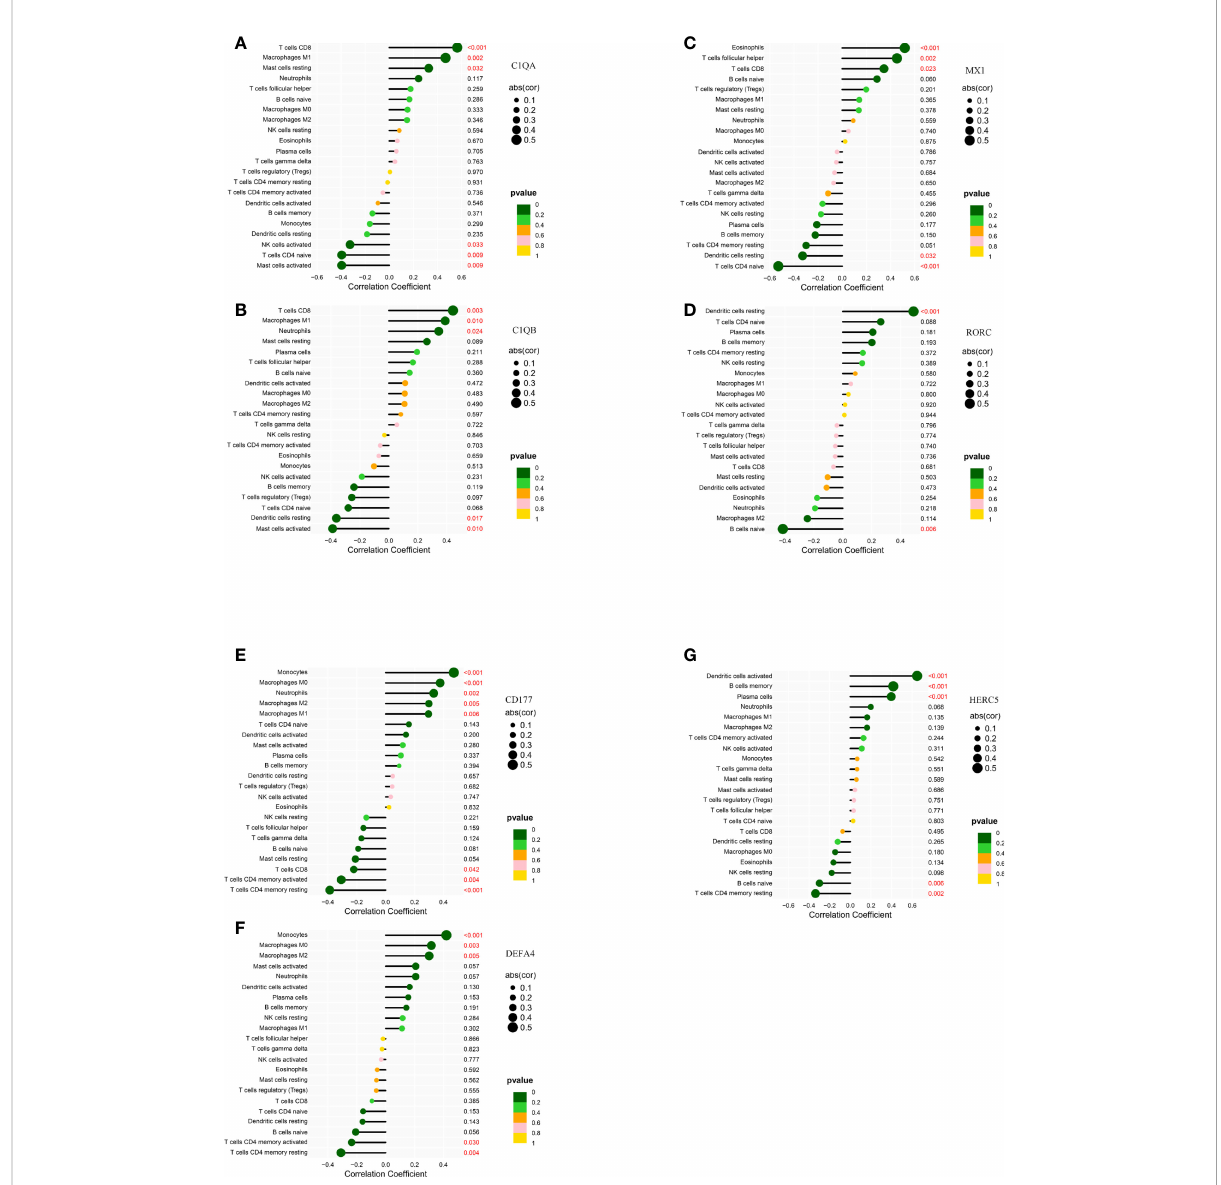
FIGURE 8 Correlation of LN kidney tissue biomarkers C1QA (A) , C1QB (B) , MX1 (C) , RORC (D) and LN peripheral blood biomarkers CD177 (E) , DEFA4 (F) , HERC5 (G) with in fi ltrating immune cells. The vertical ordinate represents the name of the immune cell and the abscissa represents the correlation coef fi cient. The circle size represents the absolute value size of the correlation coef fi cient, and the color of the circle represents the P value of the correlation test. If p value < 0.05, p values are indicated in